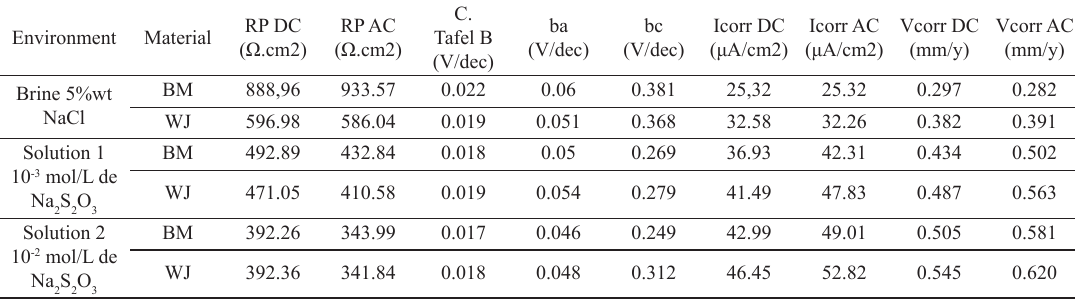
Table 3. Average corrosion rates values obtained by loss weight tests, LPR and EIS techniques. Environment